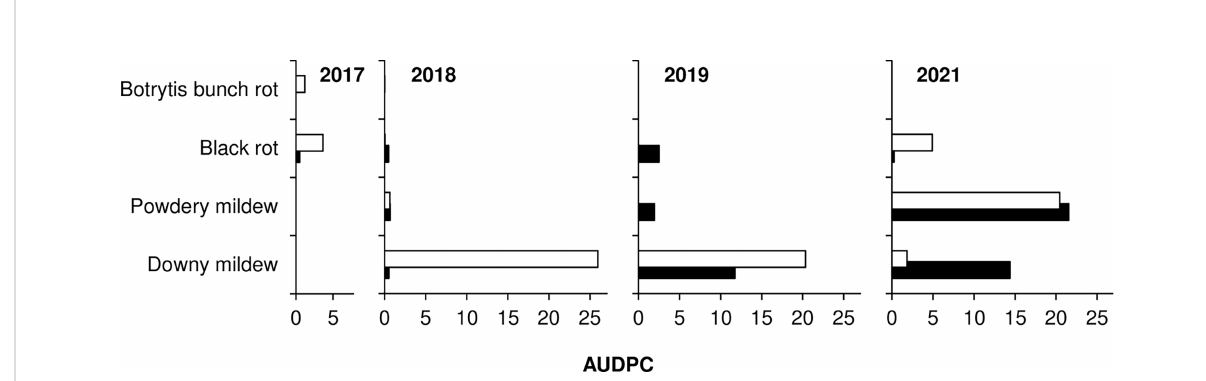
FIGURE 2 Values of AUDPC (area under the disease progress curve) on leaves (black bars) and bunches (white bars) for the susceptible variety ‘ Merlot ’ (the positive control) for downy mildew, powdery mildew, black-rot, and Botrytis bunch rot in 2017, 2018, 2019, and